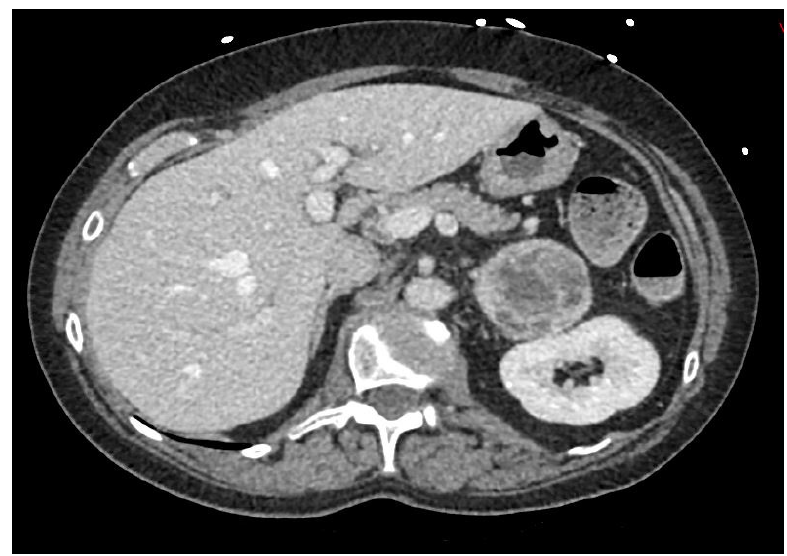
Figure 2. Abdominal CT (DFOV 85 × 37mm): Pheochromocytoma, left heterogenous adrenal tumor.